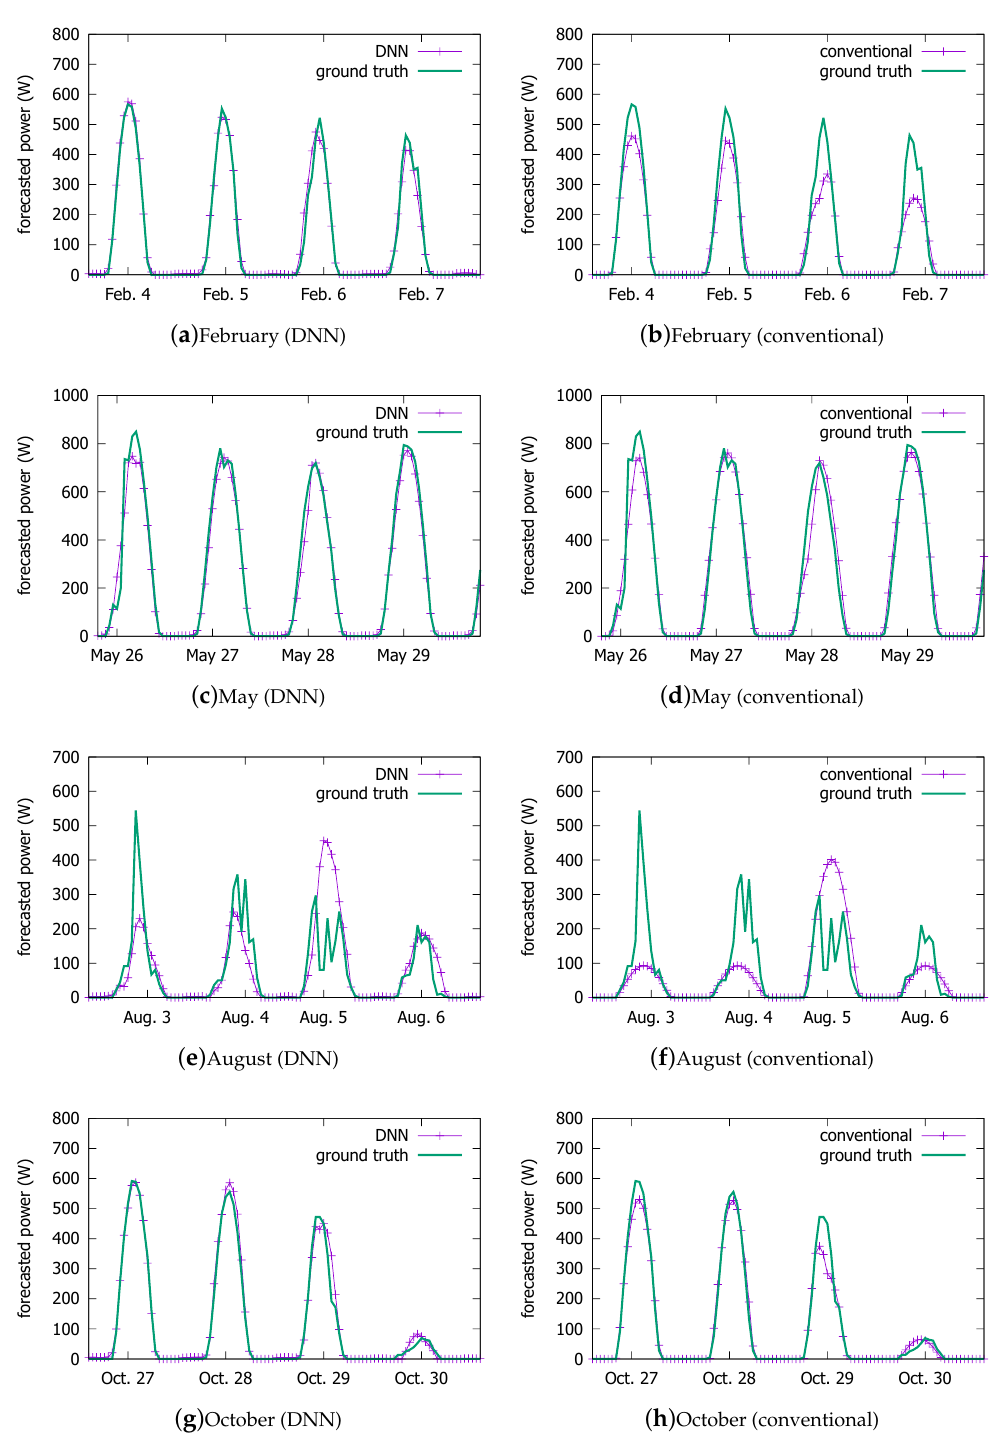
Figure 15. Forecast performance comparison against ground truth on some days over a year: the DNN model on the left column and the current system on the